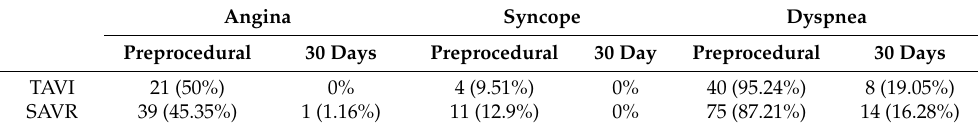
Table 3. The 30-day clinical